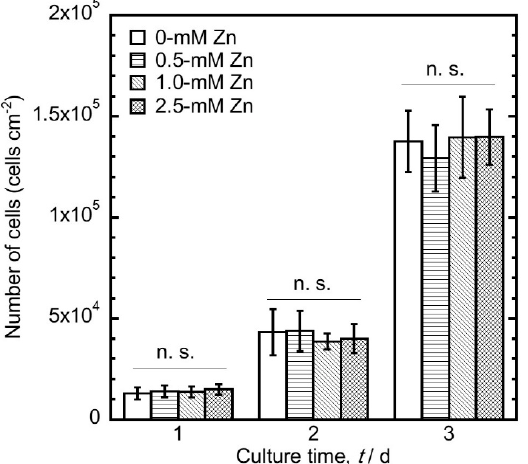
Figure 8. Number of MC3T3-E1 cells on Ti MAO-treated in the electrolyte containing various concentrations of Zn with culture time. Data are shown as the mean ± SD. n.s.: No significant difference ( n ≥ 5, P < 0.05).